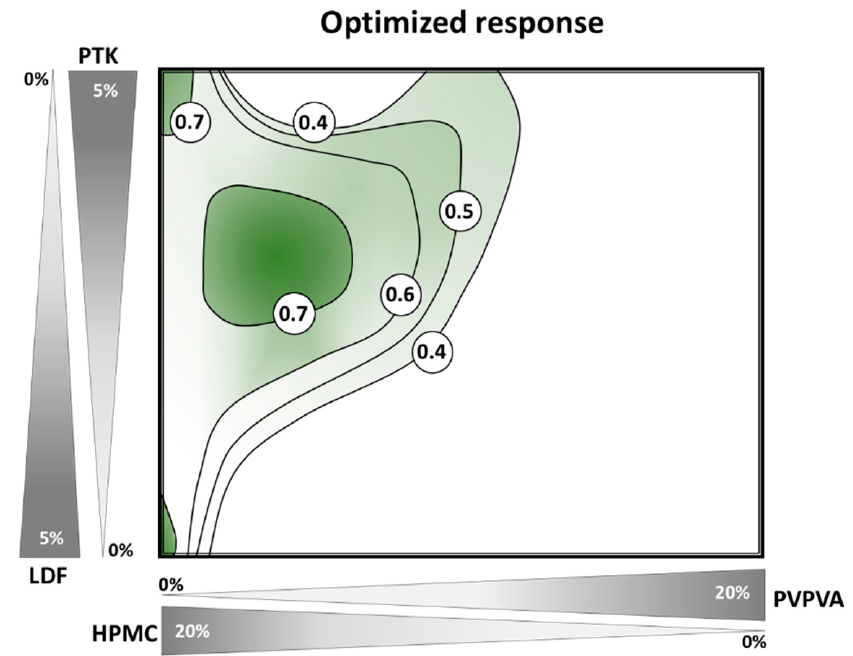
Figure 8. Response surface for the optimized response (desirability index) of effervescent formulations produced by HME, considering moisture content, disintegration time, compressibility, and drug solubilization. The green regions show compositions within better pharmaceutical performance.